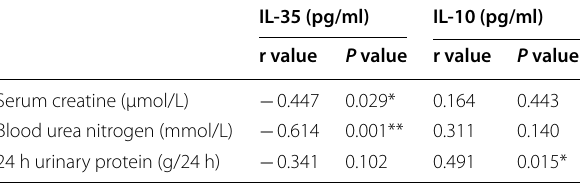
Association of serum cytokines with CD24 high CD27 + B cells in SLE patients